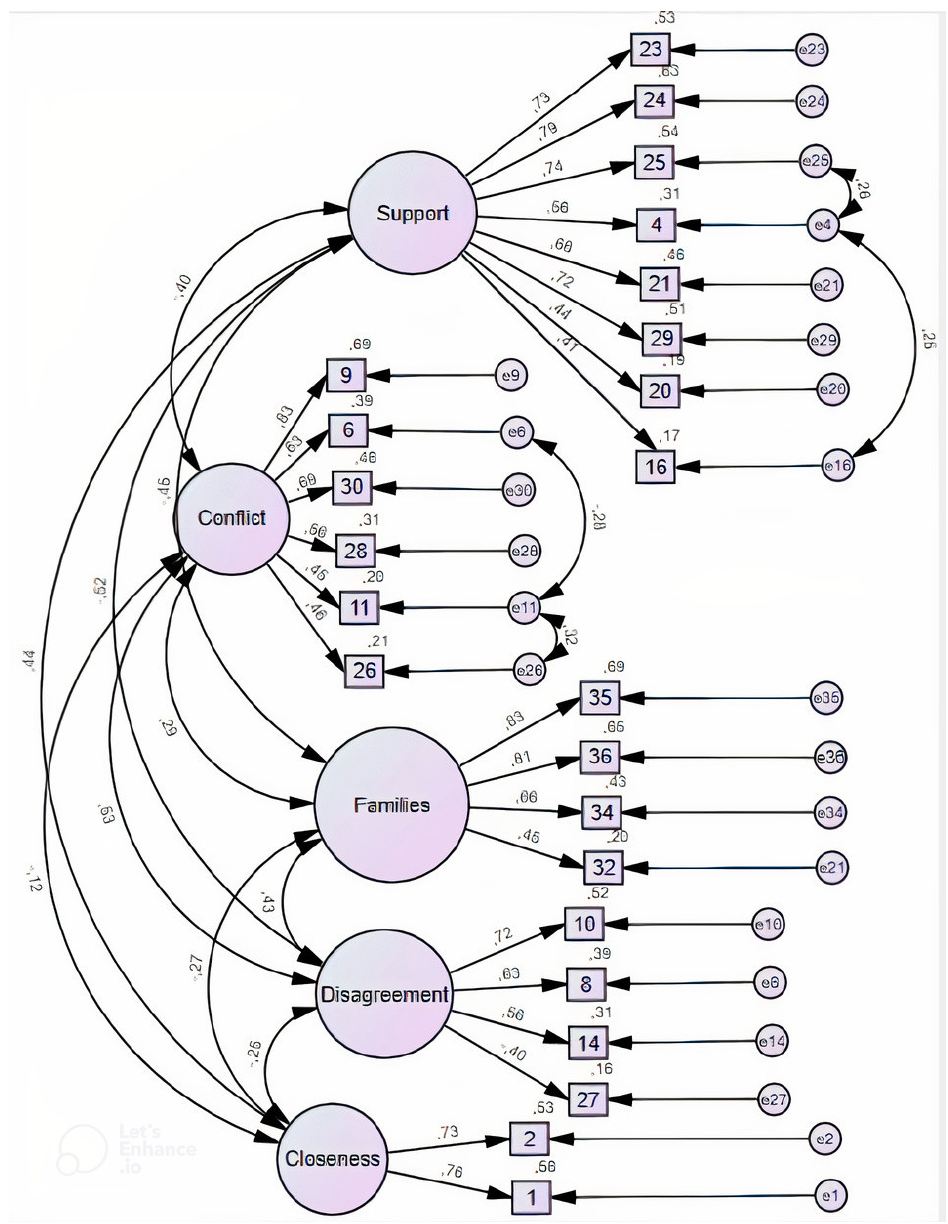
Figure 3. Final Factorial Structure of Prospective Coparenting Relationship Scale (PCRS) in a Heter- osexual Sample, N = 176.